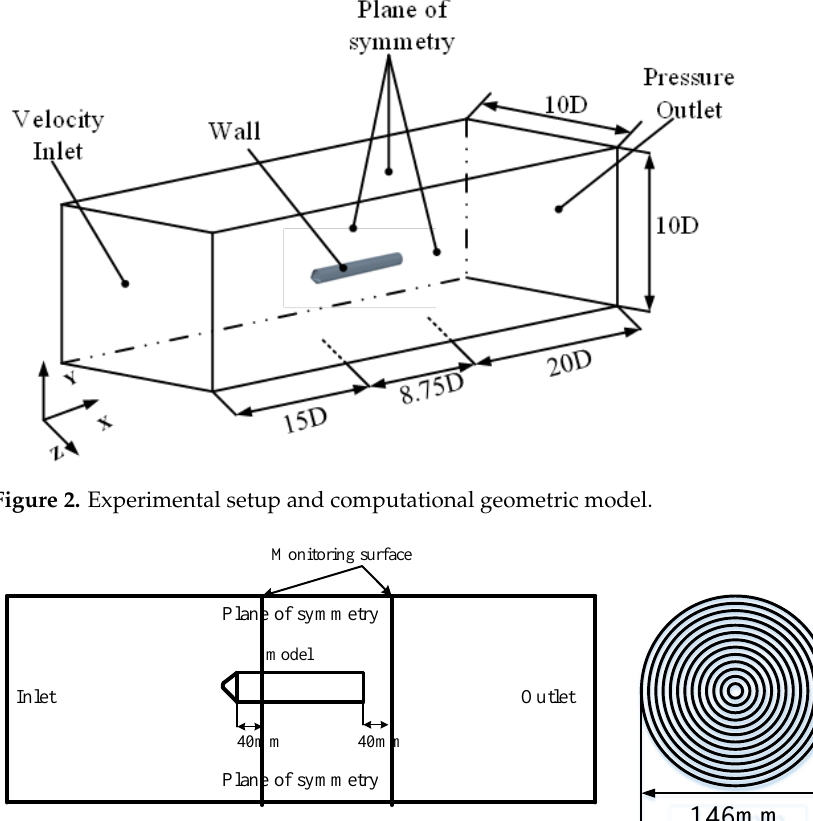
Figure 3. ( a ) Position of the monitoring surface in the two-dimensional calculation domain; ( b ) rear view of the monitoring surface.